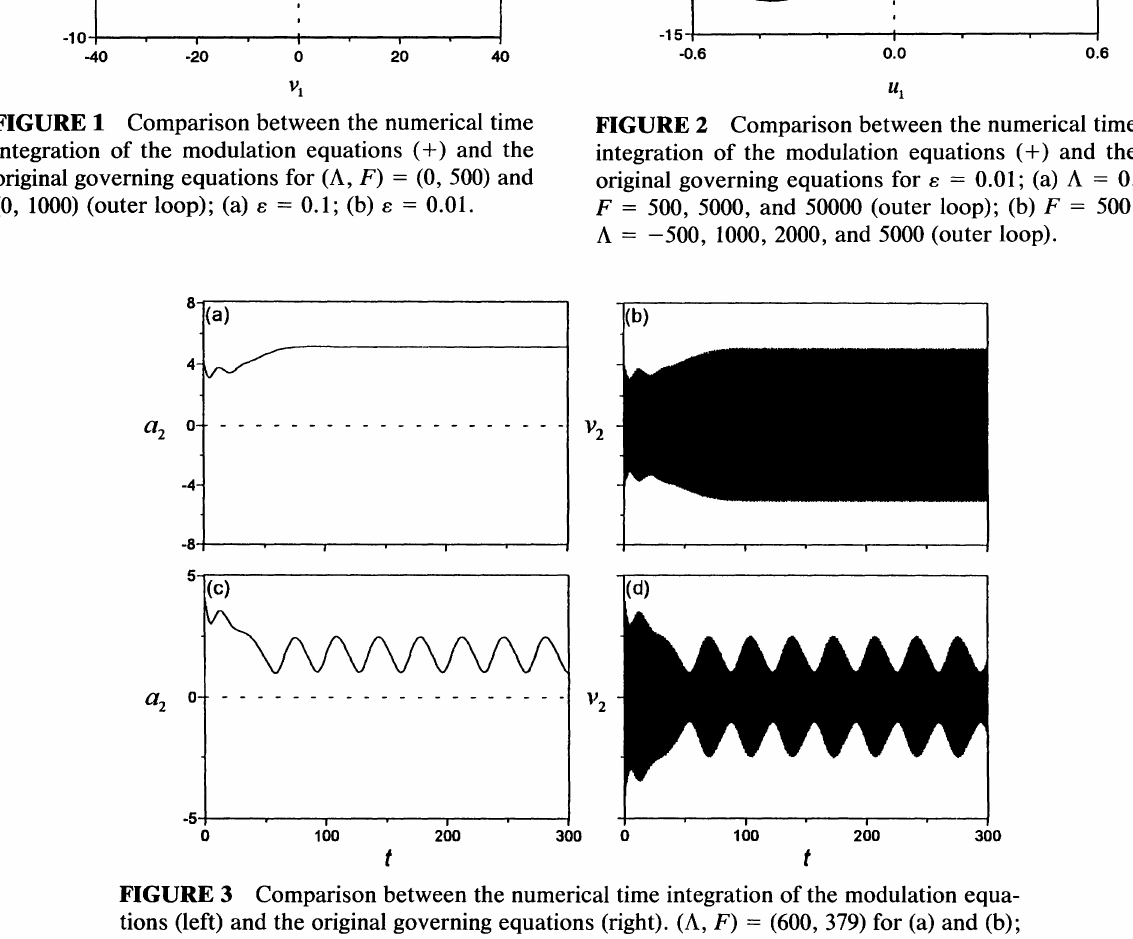
FIGURE 1 Comparison between the numerical time integration of the modulation equations (+) and the original governing equations for (A, F) = (0, 500) and (0, 1000) (outer loop); (a) B = 0_1; (b) B = 0_01.